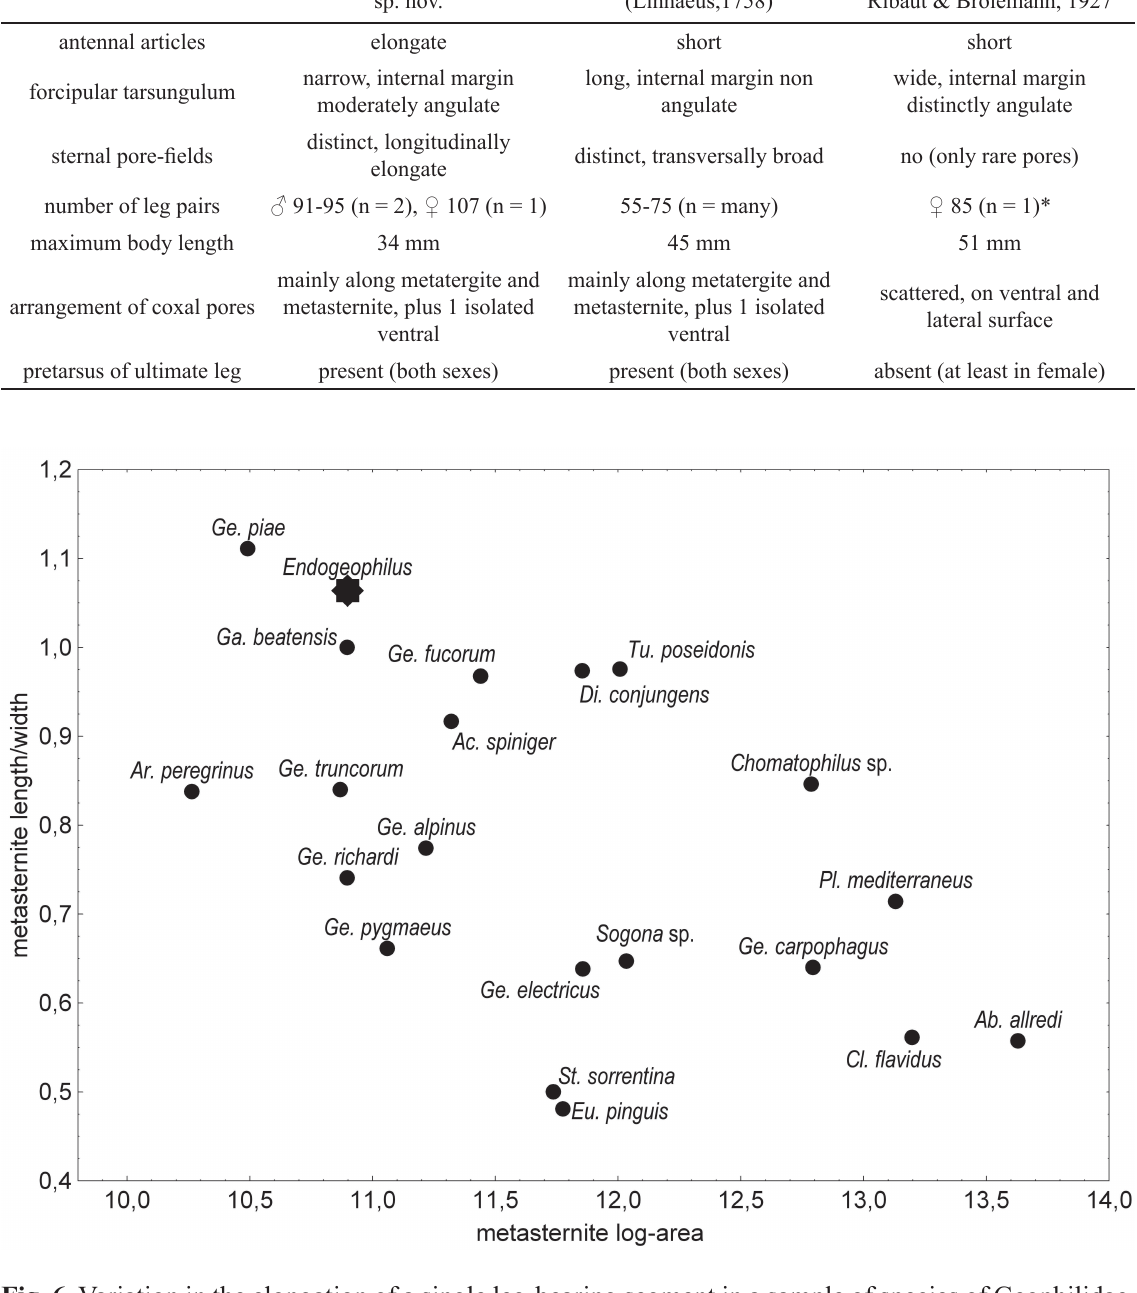
Fig. 6. Variation in the elongation of a single leg-bearing segment in a sample of species of Geophilidae, including Endogeophilus ichnusae gen. et sp. nov. The length/width ratio was measured on a metasternite at about 20% of the longitudinal series of leg-bearing segments, and the area of the metasternite (length × width, both in µm, log-transformed) has been taken as a proxy for body size. Full names of species in ‘Material and